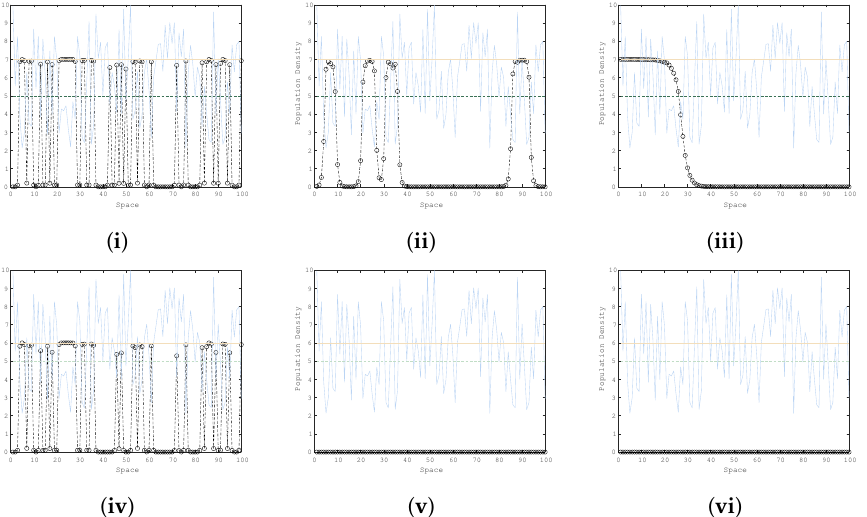
Figure 3. The subpopulation size (the black circles) vs space, i.e., at different patches, obtained for the initial condition u i ( 0 ) = 5 (the dashed green line), for different coupling ( q = 0.1 in ( i , iv ), q = 2 in ( ii , v ) and q = 20 in ( iii , vi )) and different Allee threshold ( β = 7 in ( i – iii ) and β = 6 in ( iv – vi ), as shown by the orange line). The thin blue broken line show the random carrying